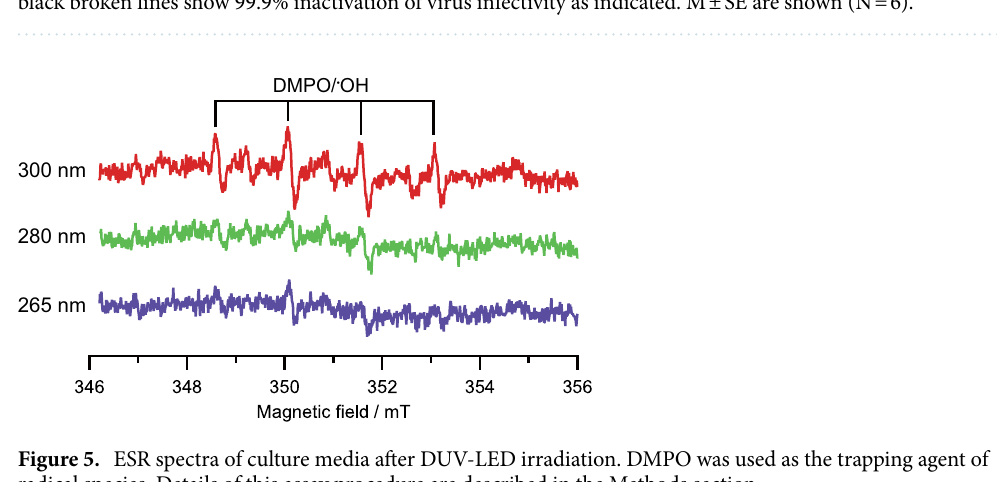
Figure 4. Effects of DUV-LEDs on SARS-CoV-2 inactivation. ( a ) Plaque assays. Virus samples were diluted with PBS containing 2% FBS and exposed to DUV-LEDs for various irradiation time periods. The irradiated samples were appropriately diluted, if necessary, for plaque assays as described in Fig. 1b. Representative data from six independent assays are shown. ( b ) Inactivation efficacy at various total doses of DUV-LED energy. The black broken lines show 99.9% inactivation of virus infectivity as indicated. M ± SE are shown (N = 6).